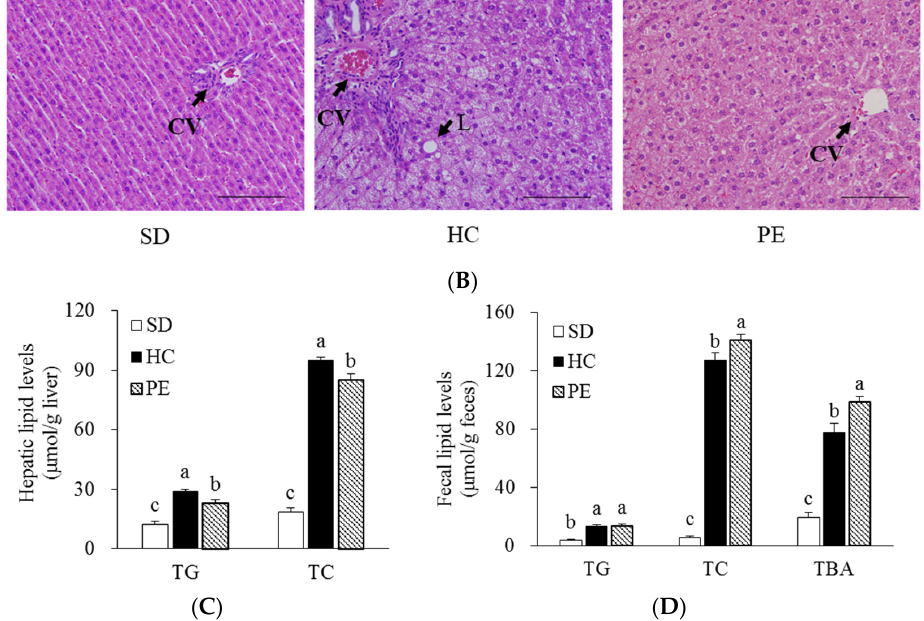
Figure 1. Effects of PE on serum ( A ), hepatic ( C ), and fecal lipid profiles ( D ). ( B ) Representative H&E stained liver tissue (scale bars = 100 μ m; magnification of 400×). Data are expressed as mean ± SE ( n = 8). Bars with different letters (a, b, c) are statistically different at p < 0.05 by Tukey’s test. SD, standard diet; HC, high ‐ cholesterol; PE, HC + 0.8% extruded Portulaca oleracea L. extract; HDL ‐ C, high ‐ density lipoprotein ‐ cholesterol; LDL ‐ C, low ‐ density lipoprotein ‐ cholesterol; TBA, total bile acid; TC, total cholesterol; TG, triglyceride; CV, central vein; L, lipid deposition.